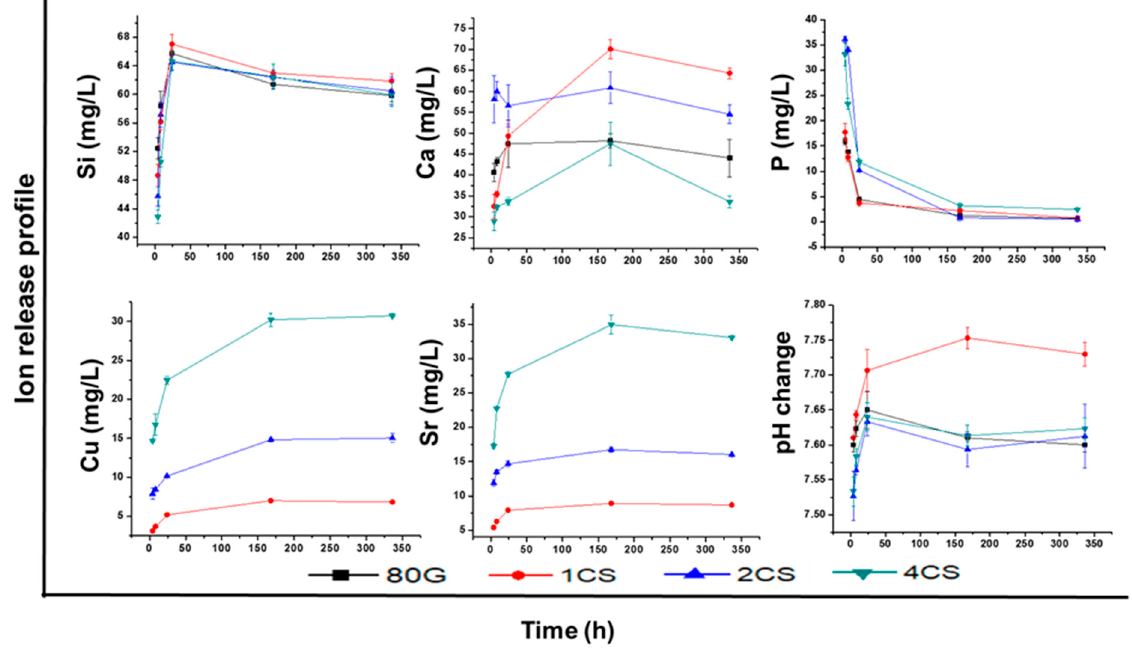
Figure 5. Release profile Si, Ca, P, Cu and Sr ions (mg/L) in SBF and pH measurements for base glass (80G) and co-doped MBG (1CS, 2CS and 4CS).